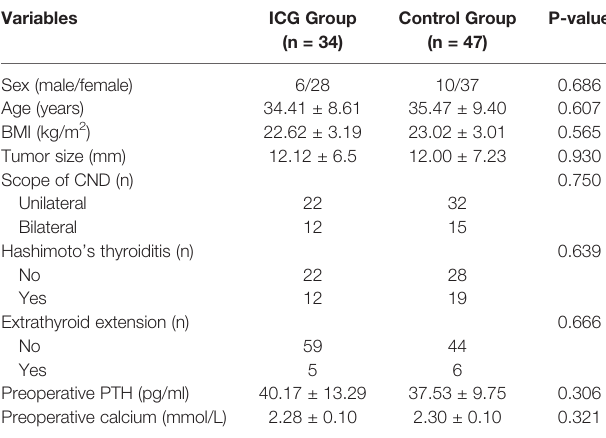
TABLE 1 | Demographic and clinical characteristics of the patients in the two groups.